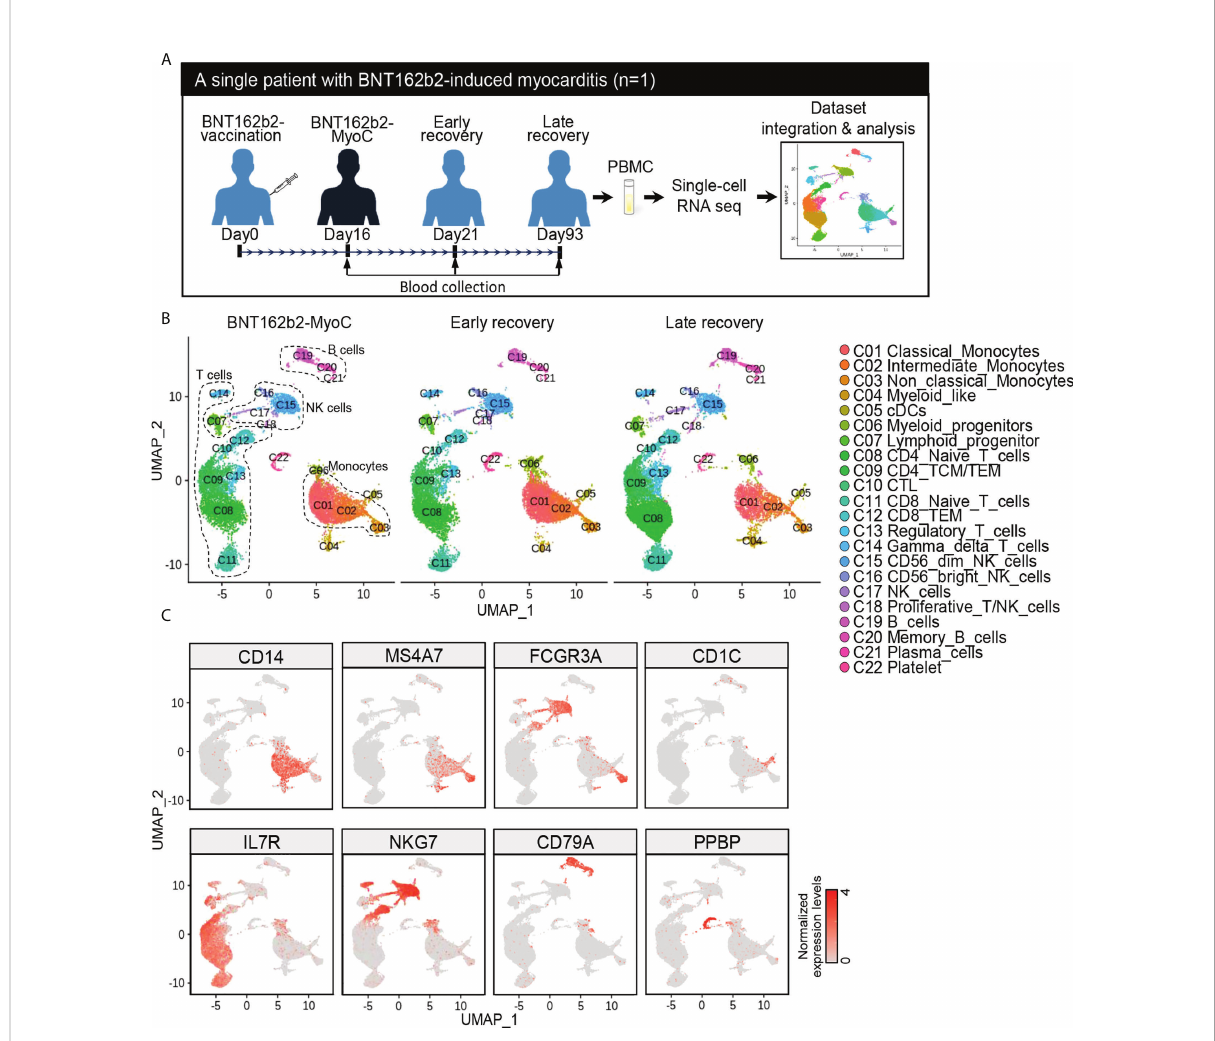
FIGURE 1 Time Series Analysis of Single-Cell RNA Sequencing Data of PBMCs of a Patient with BNT162b2-MyoC. (A) Overview of single-cell RNA-seq analysis of the PBMCs from patient in the stage of myocarditis(day16), early(day21), and late(day93) recovery stage after BNT162b2 administration, respectively. The samples were performed single-cell RNA-seq and integrated to one dataset with Harmony. (B) The dimensional reduction is performed with the uniform manifold approximation and projection (UMAP). Each dot represents a cell in each corresponding group, and is colored according to cell type The cells are pooled across all patients and separated by conditions: Myocarditis after BNT62b2-administration (BNT162b2- MyoC, left), early (middle), and late (left) recovery stages. Total number of cells per group: Myocarditis (n = 10,580cells), Early recovery (n = 11,745cells) and Late recovery(n = 13,065cells). (C) Normalized expression levels of marker genes for each immune cell type on UMAP plots. CD14 (Classical monocytes and Intermediated monocytes), MS4A7 and FCGR3A (Intermediated monocytes and Non-classical Monocytes), CD1C (Dendritic cells (cDCs)), IL7R (T cells), NKG7(Natural killer cells (NK cells)), CD79A (B cells), and PPBP